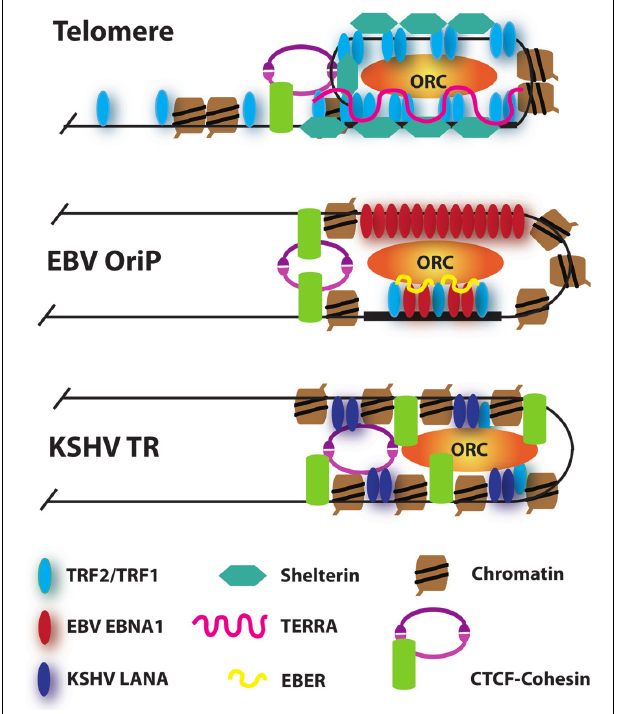
FIGURE 2 | Model of higher order chromatin structures at telomeres and viral maintenance elements. RNA-dependent recruitment of ORC at telomeres and EBV OriP is indicated. Elevated histone H3K4me3 and CTCF-cohesin enrichment is found at all three maintenance elements . TRFs are localized to the latent origin of both EBV and